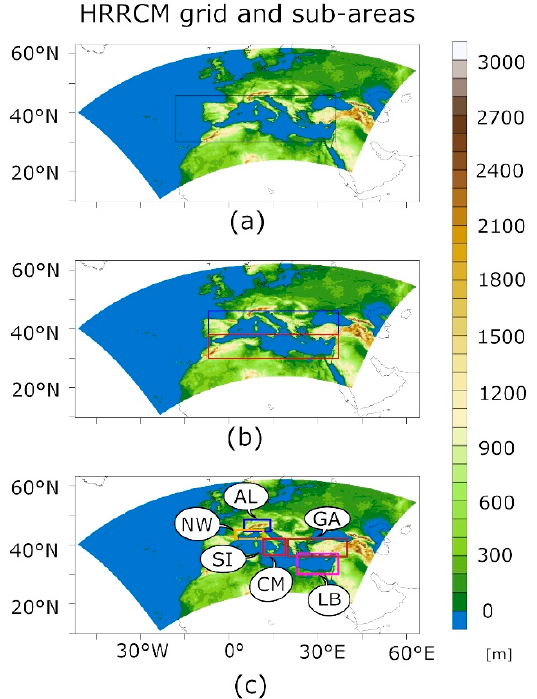
Figure 1. Regional climate models (RCM) domain with: the NEMO ocean model domain (panel ( a ), thin black rectangle); sub-regions used for computing temperature and precipitation trends (North Mediterranean and Southern Mediterranean, blue and red rectangles, respectively, panel ( b )), the six boxes for computing the precipitation probability(panel ( c )): Alps region (AL, blue rectangle); North-West Mediterranean coast (NW, orange rectangle); South Italy and Central Mediterranean Sea (SI and CM, red rectangle); Greece and Anatolian Peninsula (GA, brown rectangle); Levantine Basin (LB, magenta rectangle).